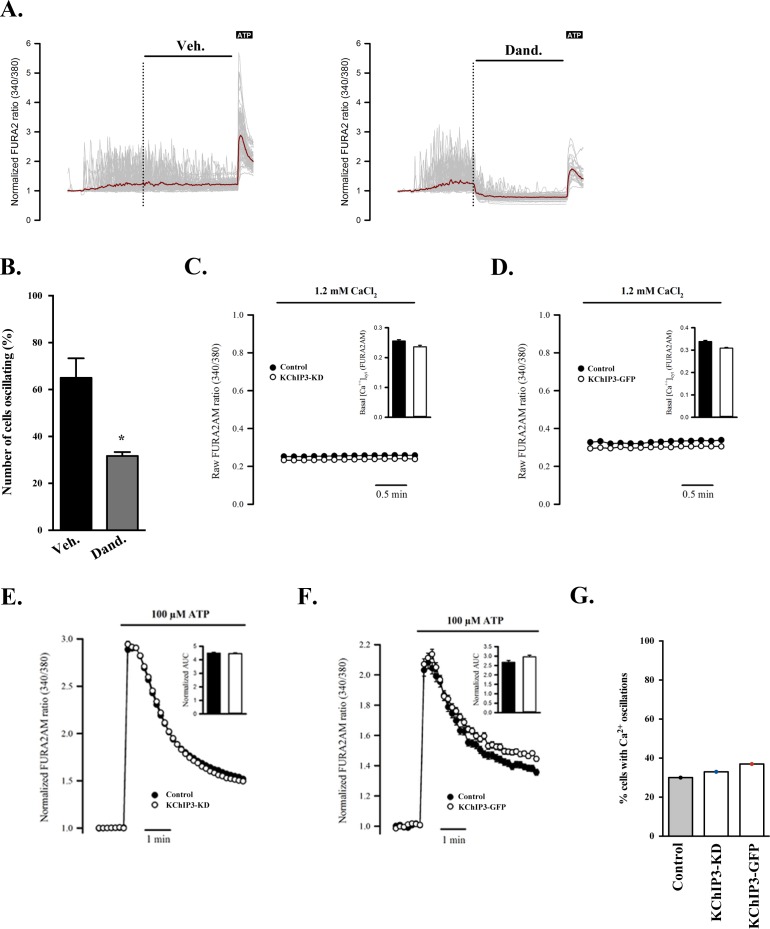
KChIP3 does not control Ca2+ levels.(A) Time course of Ca2+ responses (normalized FURA-2AM ratio) (in grey individual cells, in red average trace) obtained in differentiated HT29-18N2 cells in a buffer containing 0.5 mM EGTA to trigger high levels of Ca2+ oscillations. After 5 min of recording, cells were treated with vehicle (DMSO) (left) or 10 µM dandrolene (right). At minute 15, cells were stimulated with 100 µM ATP. (B) Percentage of cells oscillating in each condition presented in (A) during 10 min after starting the treatment. Results are average values ± SEM (N > 3). (C) Time course of mean basal intracellular Ca2+ levels (normalized FURA-2AM ratio) in KChIP3-KD and control cells. (D) Time course of mean basal intracellular Ca2+ levels (normalized FURA-2AM ratio) in KChIP3-GFP and control cells. (E) Time course of mean Ca2+ responses (normalized FURA-2AM ratio) obtained in differentiated control (black) and KChIP3-KD (white) cells treated with 100 µM ATP (left panel). Average AUC (Area Under the Curve) from the traces are showed as a bar graph. (F) Time course of mean Ca2+ responses (normalized FURA-2AM ratio) obtained in differentiated control (black) and KChIP3-GFP (white) cells treated with 100 µM ATP (left panel). Average AUC (Area Under the Curve) from the traces are showed as a bar graph. (G) Percentage of cells oscillating in KChIP3-KD, KChIP3-GFP and control cells during 10 min in normal buffer (1.2 mM CaCl2). Abbreviations: Veh: Vehicle (DMSO), Dand: dandrolene. *p<0.05.